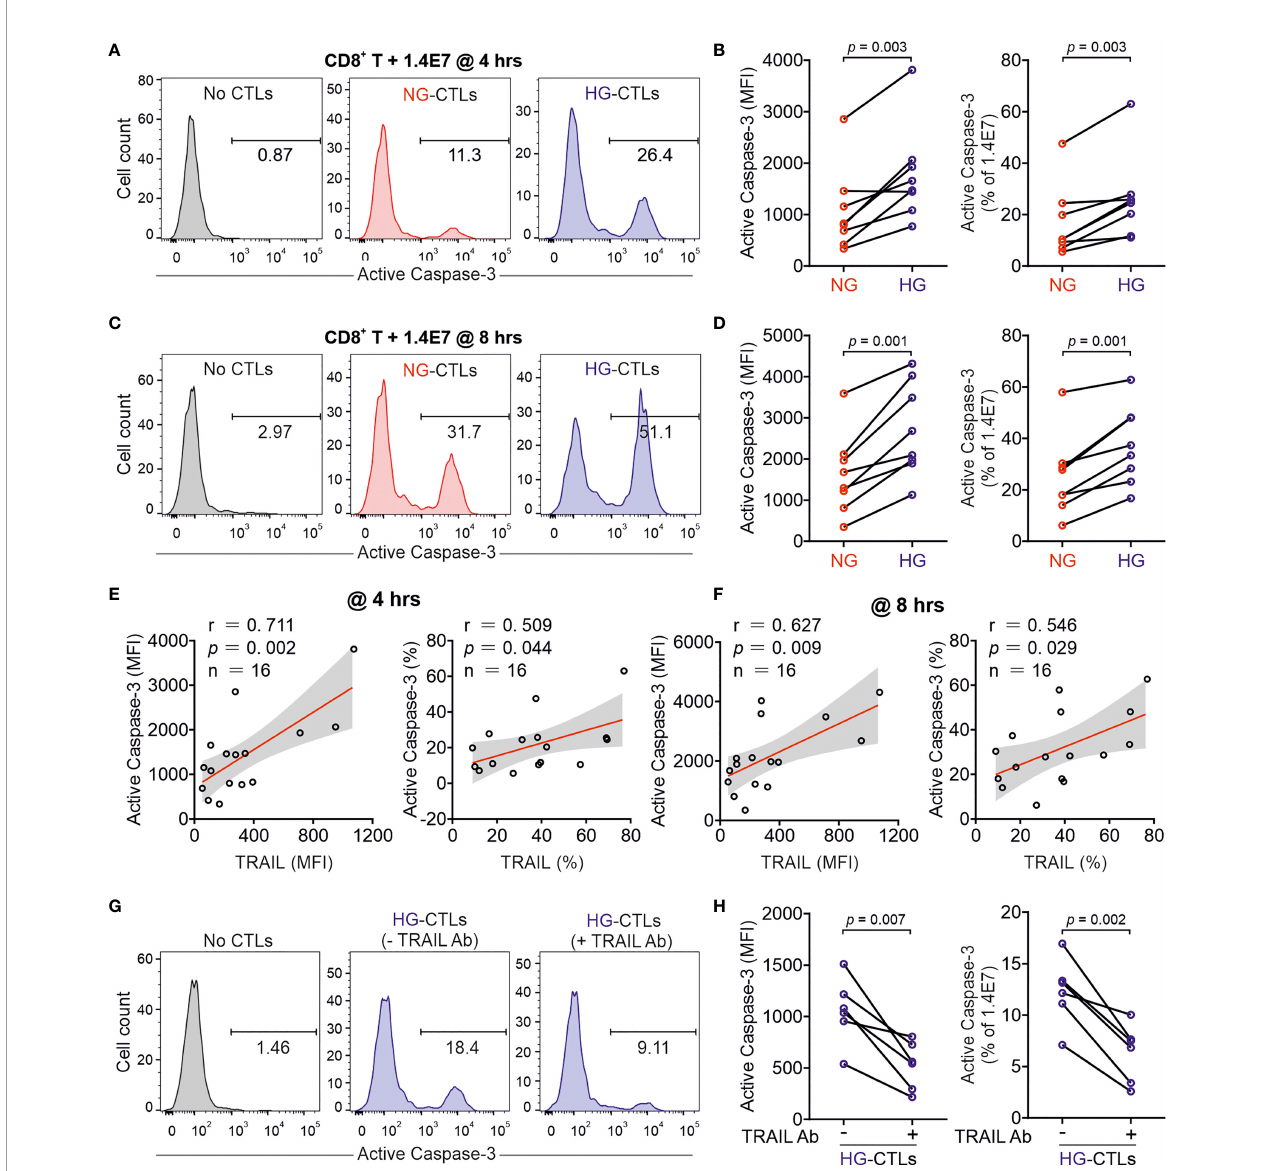
FIGURE 2 | Up-regulation of TRAIL in HG-CTLs enhances apoptosis of pancreatic beta cells. Primary human CD8 + T cells were stimulated with CD3/CD28 beads for 3 days in NG (5.6 mM) or HG (25 mM) medium. (A – D) Apoptosis of pancreatic beta cells induced by CTLs were measured by staining active Caspase-3 using fl ow cytometry. Human pancreatic beta cells 1.4E7 were incubated with CTLs with an effector to target (E:T) ratio of 20:1 for 4 hours (A, B) or 8 hours (C, D) (n = 8 donors from fi ve independent experiments). One representative donor out of eight is shown in (A, C) respectively. (E, F) Correlation of expression of TRAIL in CD8 + T cells with apoptosis of 1.4E7 cells (Caspase-3 activity) (n = 16 donors from fi ve independent experiments). (G, H) CD8 + T cells-induced beta cell apoptosis is TRAIL dependent. Caspase-3 activity was analyzed in co-culture of 1.4E7 cells and CTLs in the presence or absence of anti-human TRAIL antibody (50 µg/ml) for 4 hours. One representative donor is shown in (G) and the quanti fi cation is shown in (H) (n = 6 donors from two independent experiments). MFI, mean fl uorescent intensity. Data were analyzed by two-tailed paired Student ’ s t test (B, D, H) or Pearson ’ s correlation coef fi cients (E, F) . Connected lines are the data from the same